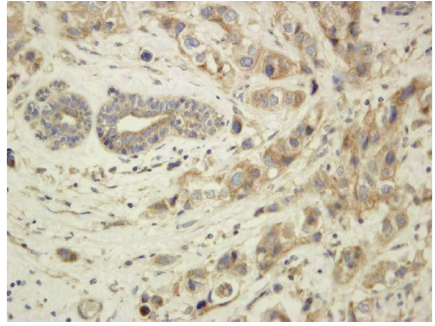
Figure 2: Microphotography of breast cancer tumour with strongly immunohistochemical staining for VEGFR-1 (brown staining) (HE; ×